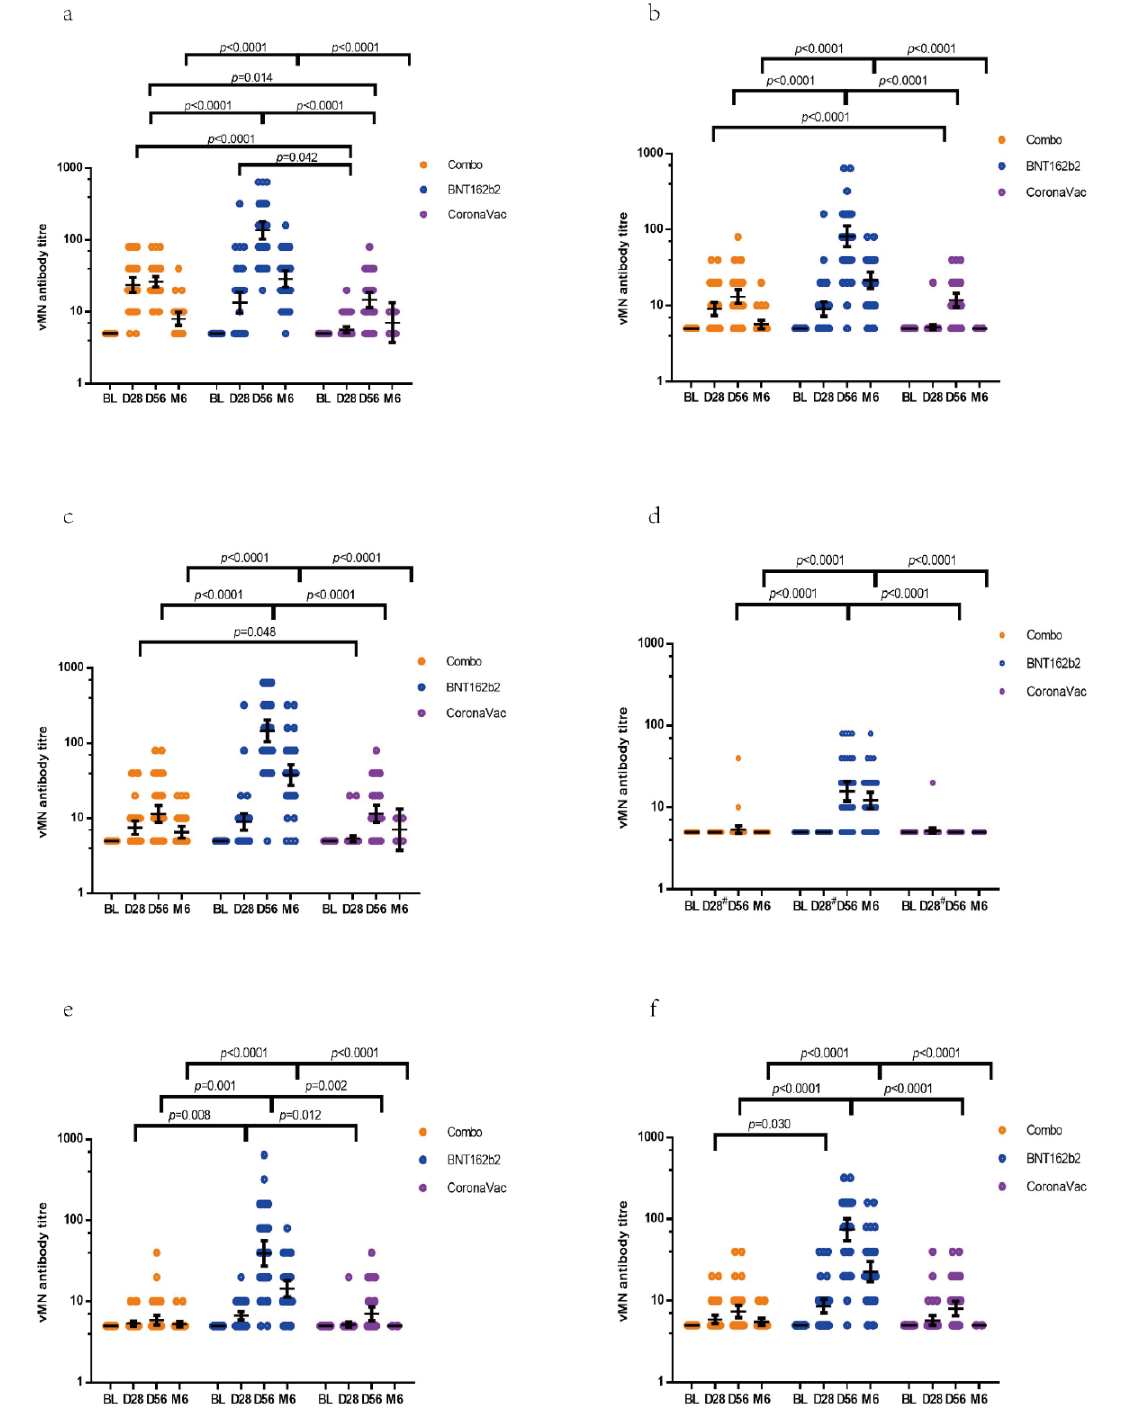
Figure 2. Comparison of immunogenicity of three vaccination strategies. SARSA-CoV-2 naïve individuals were invited to participate in the vaccination programme. In the Combo group, subjects received one dose of BNT162b2 on day 0 and one dose of CoronaVac on day 28. Then, blood samples were collected on the baseline, day 28, day 56 and month 6. For BNT162b2, subjects recieved two doses of BNT162b2 at the baseline and day 21 respectively and blood was taken at the baseline, day 21, day 56 and month 6. For CoronaVac, Individuals received two doses of CoronaVac vaccine at the baseline and day 28, respectively, and then blood was taken at the baseline, day 28, day 56 and month 6. The live virus microneutralization assay (vMN) was used to determine the level of neu- tralizing antibodies in serum against ( a ) wild type, ( b ) D614G, ( c ) alpha, ( d ) beta, ( e ) theta and ( f ) delta. BL: baseline; D28: day 28 for Combo and CoronaVac, day 21 for BNT162b2; D56: day 56; M6: